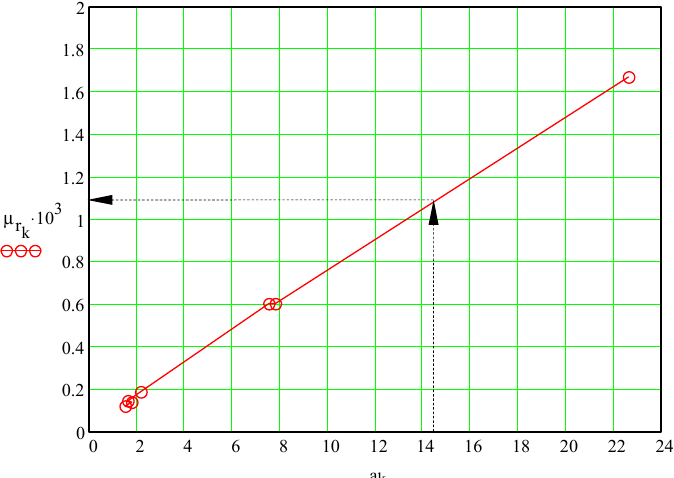
ffi cient of rolling friction versus the slope of the envelope straight Figure 19. The coefficient of rolling friction versus the slope of the envelope straight line. Figure 19. The coe